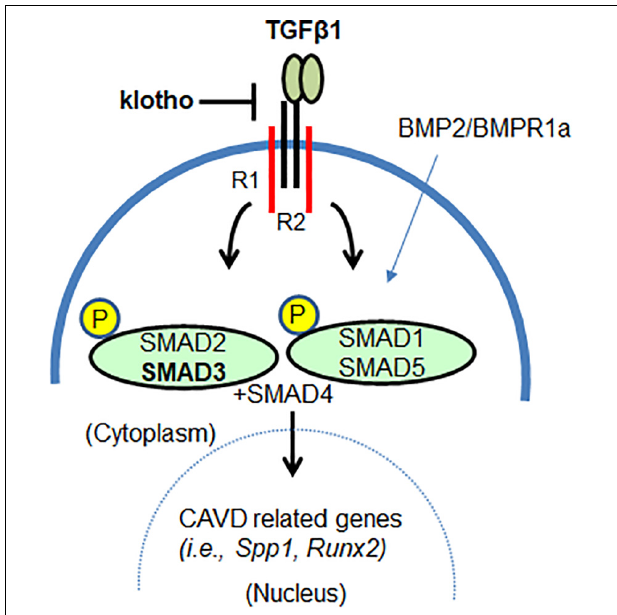
FIGURE 7 | The klotho as a mediator of TGF β 1-dependent SMAD3 signaling in AV calcification. SMAD3 can mediate klotho-dependent TGF β 1 signaling. Lowering TGF β 1-dependent SMAD3 signaling also lowers SMAD1/5 signaling. Thus, klotho functions, in part, as a mediator by restraining or attenuating the augmented TGF β /BMP signaling and TGF β -regulated transcription of genes involved in CAVD.